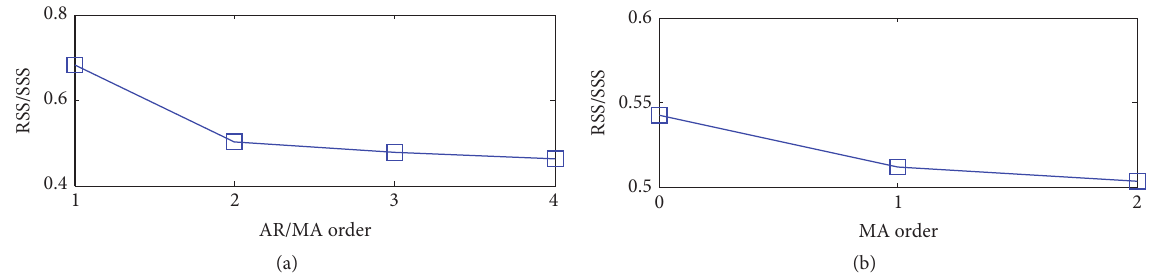
Figure 6: KRR-FS-TARMA model order selection: (a) AR order and (b) MA